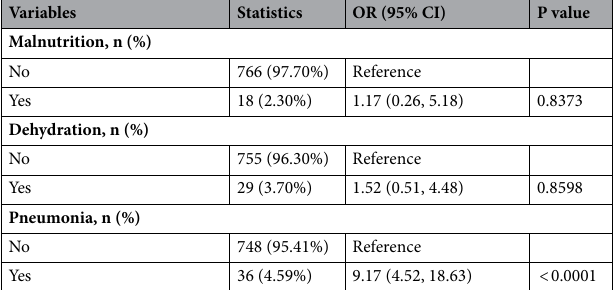
Table 2. Univariate analysis in relation to 30-day mortality. Data were depicted as OR (95% CI) P-value. Serum-phosphate tertiles: Tertile1: ≤ 0.97 mmol/L; Tertile2: 0.98–1.12 mmol/L; Tertile3: ≥ 1.13 mmol. Serum- magnesium tertiles: Tertile1: ≤ 0.78 mmol/L; Tertile2: 0.79–0.84 mmol/L; Tertile3: ≥ 0.85 mmol/L. GPR serum glucose to potassium ratio, AF atrial fibrillation/atrial flutter, COPD chronic obstructive pulmonary disease, CHD coronary heart disease. § The model failed because of the small sample size.